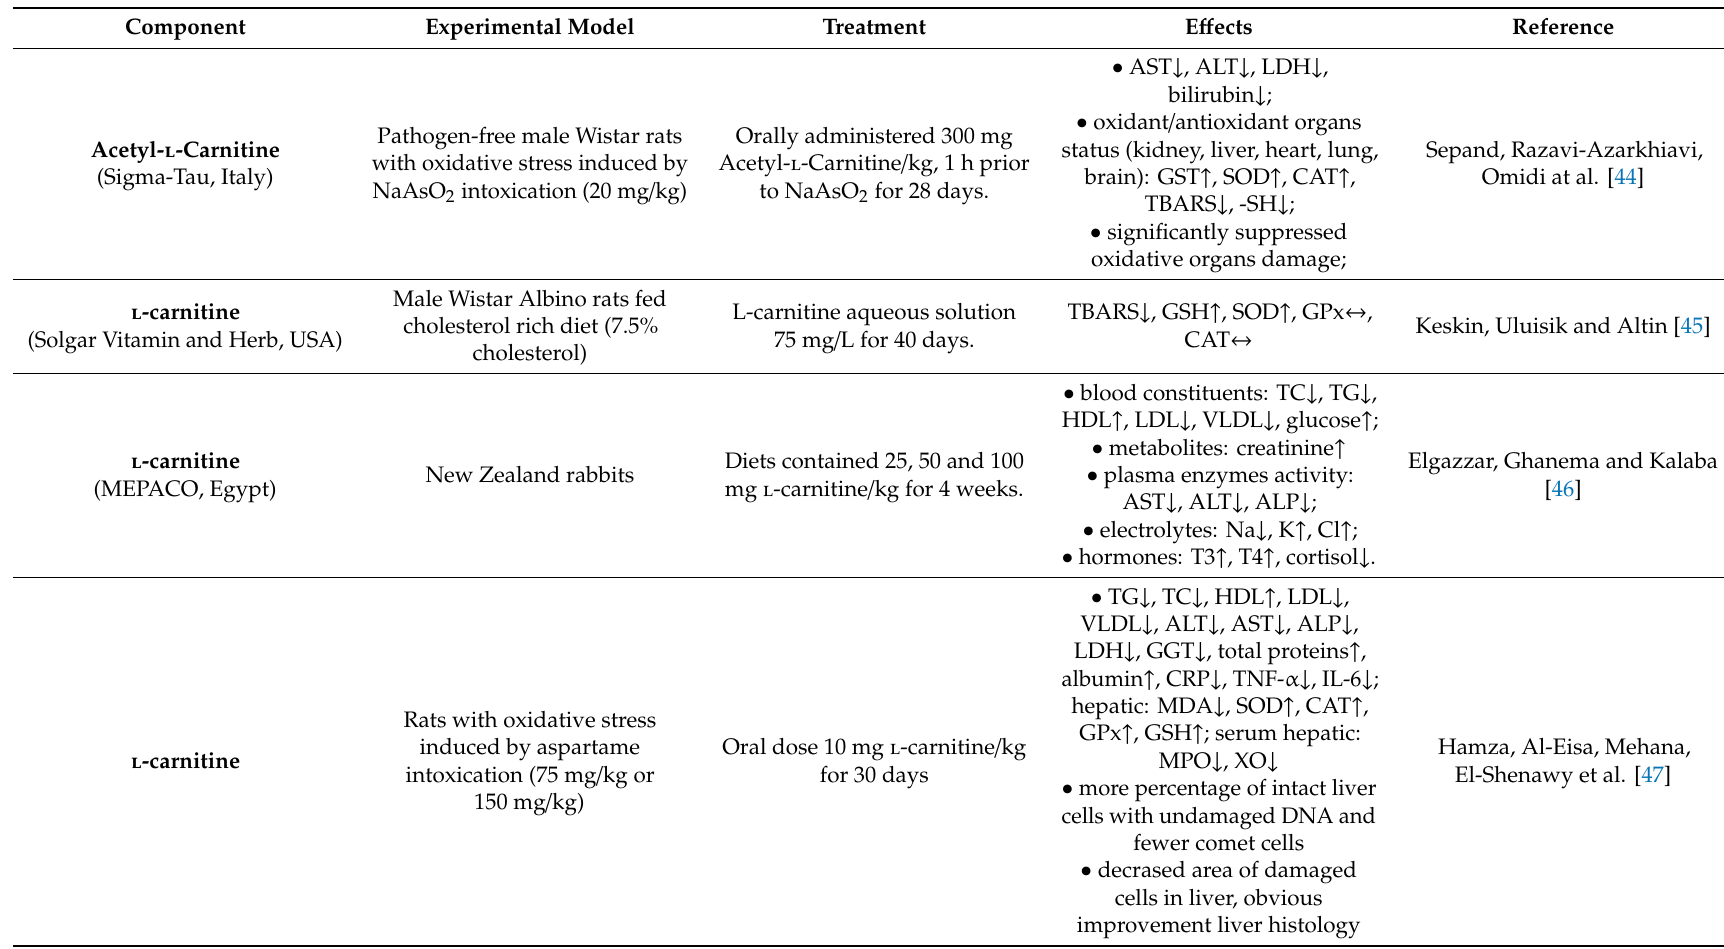
Table 2. E ff ects of meat components intake–in vivo studies performed on